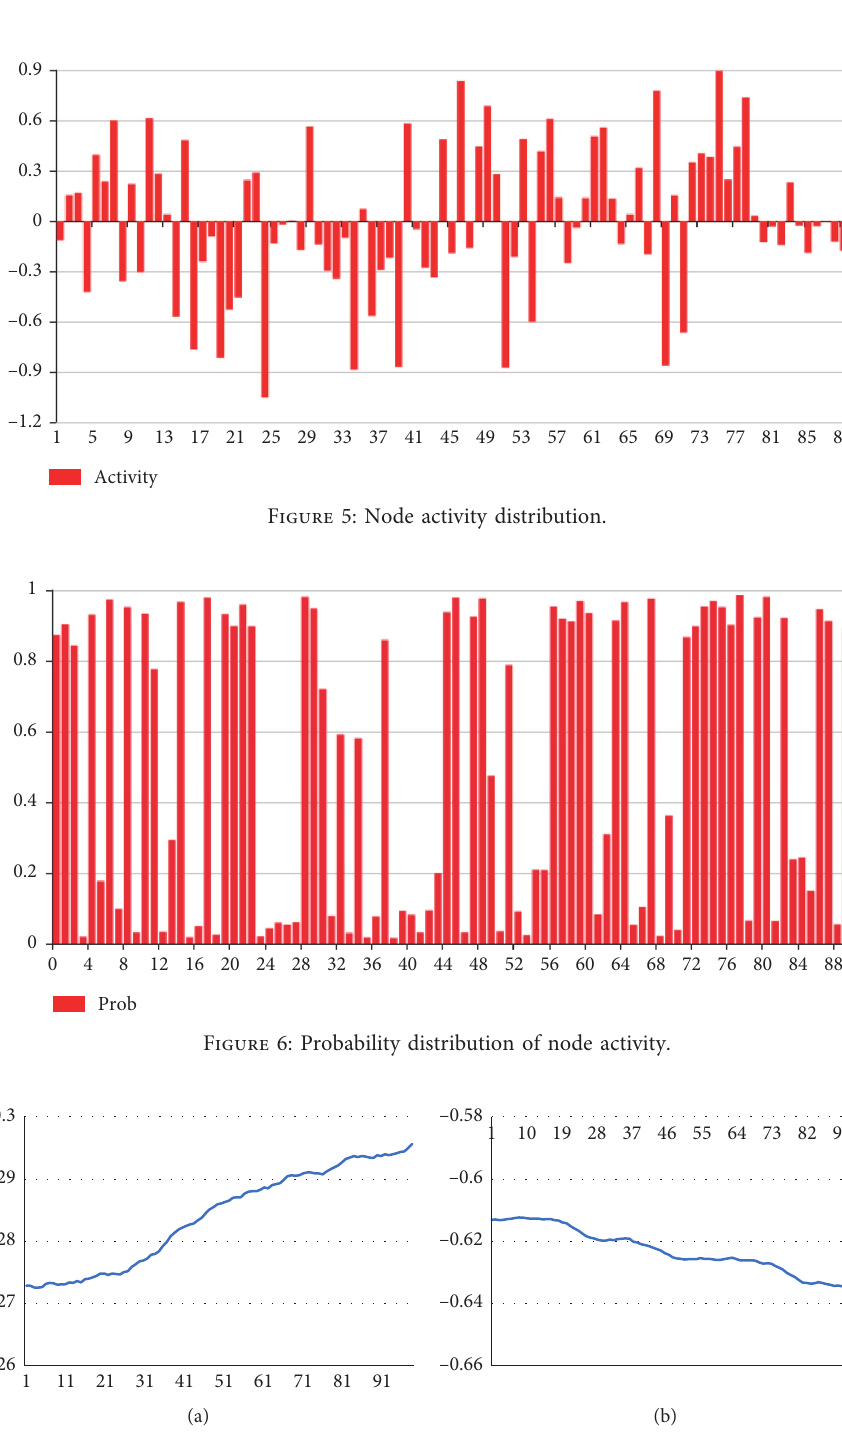
Figure 7: Time series of node activity evolution. (a) Active node ( x ). (b) Passive node ( y